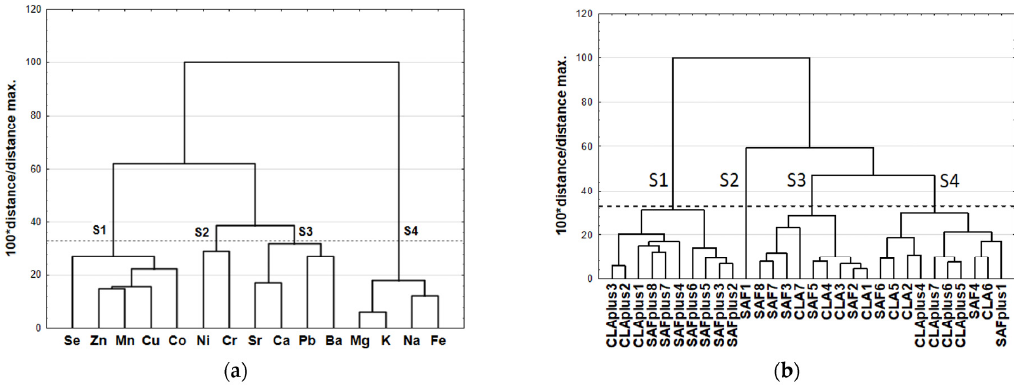
Figure 2. ( a ) Dendrogram of similarities of minerals and ( b ) their content in the myocardium of experimental groups. SAF group—animals receiving safflower oil; SAFplus group—animals receiving safflower oil treated with DMBA; CLA group—group of animals receiving Bio-C.L.A.; CLAplus group—group of animals receiving Bio-C.L.A. treated with DMBA.